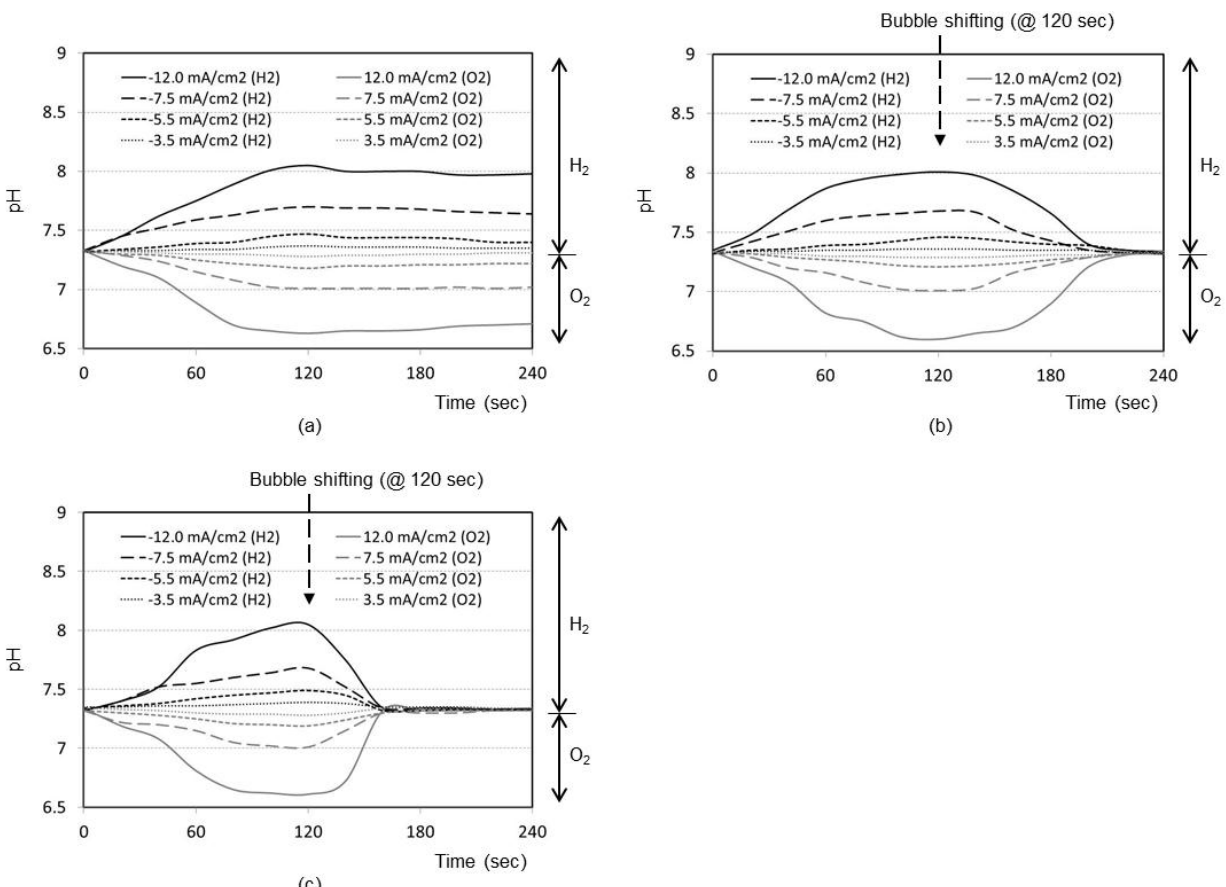
Figure 2. Responses of pH sensor during bubble generation (2 min) and shifting towards bubble stopper. Sample pH at the sensor location increases during the hydrogen generation, while it decreases during the oxygen generation, respectively. ( a ) Final distance of 5